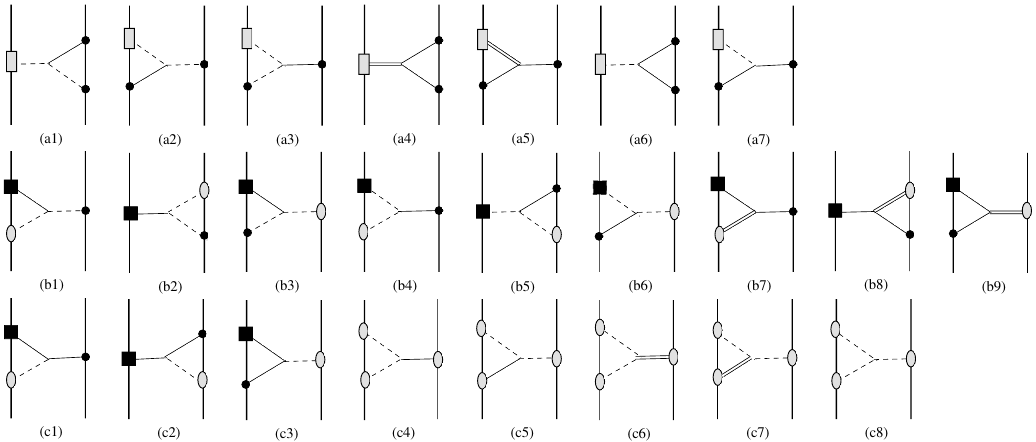
Figure 4 . The Feynman graphs at one-loop level, i.e. with cubic self-gravitational interaction, which contribute to the NLO cubic-in-spin interaction at the 4.5PN order for maximally-rotating compact objects. The graphs should be included together with their mirror images, i.e. with the worldline labels 1 ↔ 2 exchanged. Similar to the nonlinear graphs of two-graviton exchange, these graphs include all relevant interactions among the spin-induced quadrupole, octupole, and the mass and spin, and we have here nonlinearities originating from gravitons sourced strictly from minimal coupling to the worldline, as shown in graphs (c4)-(c8). We also have here cubic vertices containing time derivatives, similar to what we have in the NLO odd-parity spin-orbit sector [8, 12,